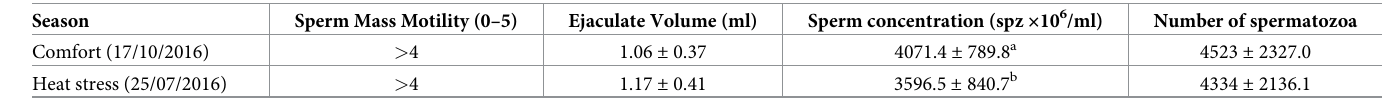
Table 2. Mean and standard deviation of sperm traits routinely assessed at the AI center between